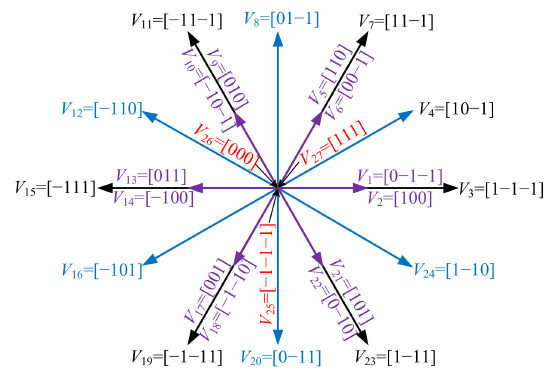
Figure 2. Space vector distribution of a 3L-NPC